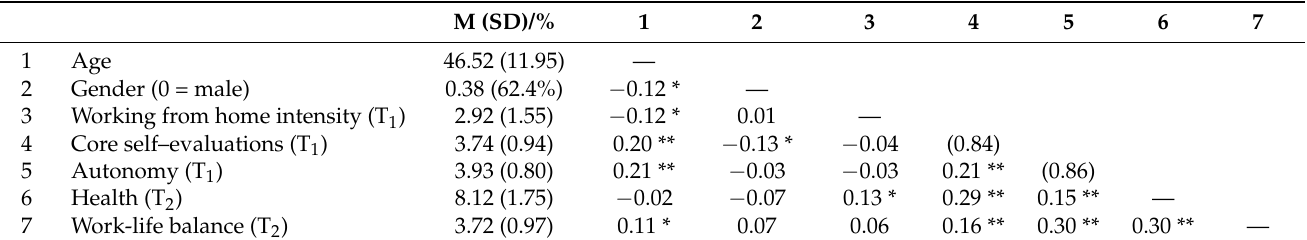
Table 1. Descriptive statistics and bivariate correlations between all study